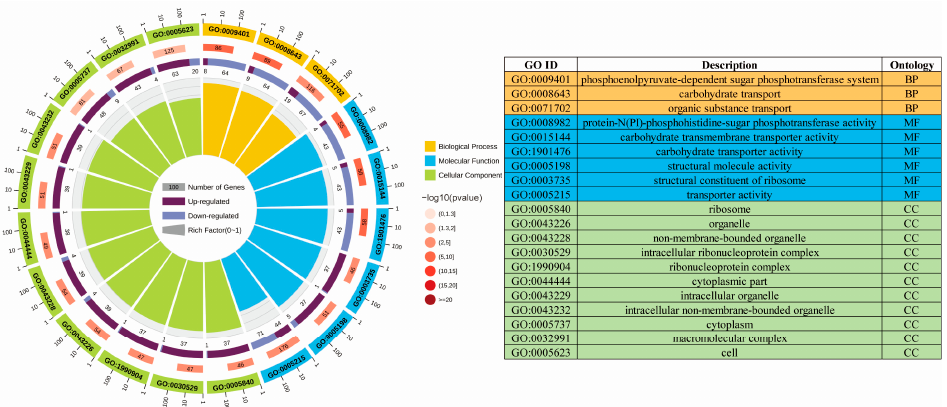
Figure 2. GO enrichment analysis of the ML group and the control. There are four circles from the outside to the inside. The first circle shows the classification of enrichment. Outside the circle is a coordinate ruler showing the number of genes. Each color represents a different category. On the second circle, the category number and the p -value are shown. A larger number of genes, a longer bar, and a smaller value results in a redder color. In the third circle, you can see the ratio of genes that are up-regulated and down-regulated; dark purple represents up-regulated genes, and light purple represents down-regulated genes. The fourth circle: the Rich Factor represents the number of foreground genes in each category divided by the number of background genes, while each cell on the background auxiliary line represents 0.1.